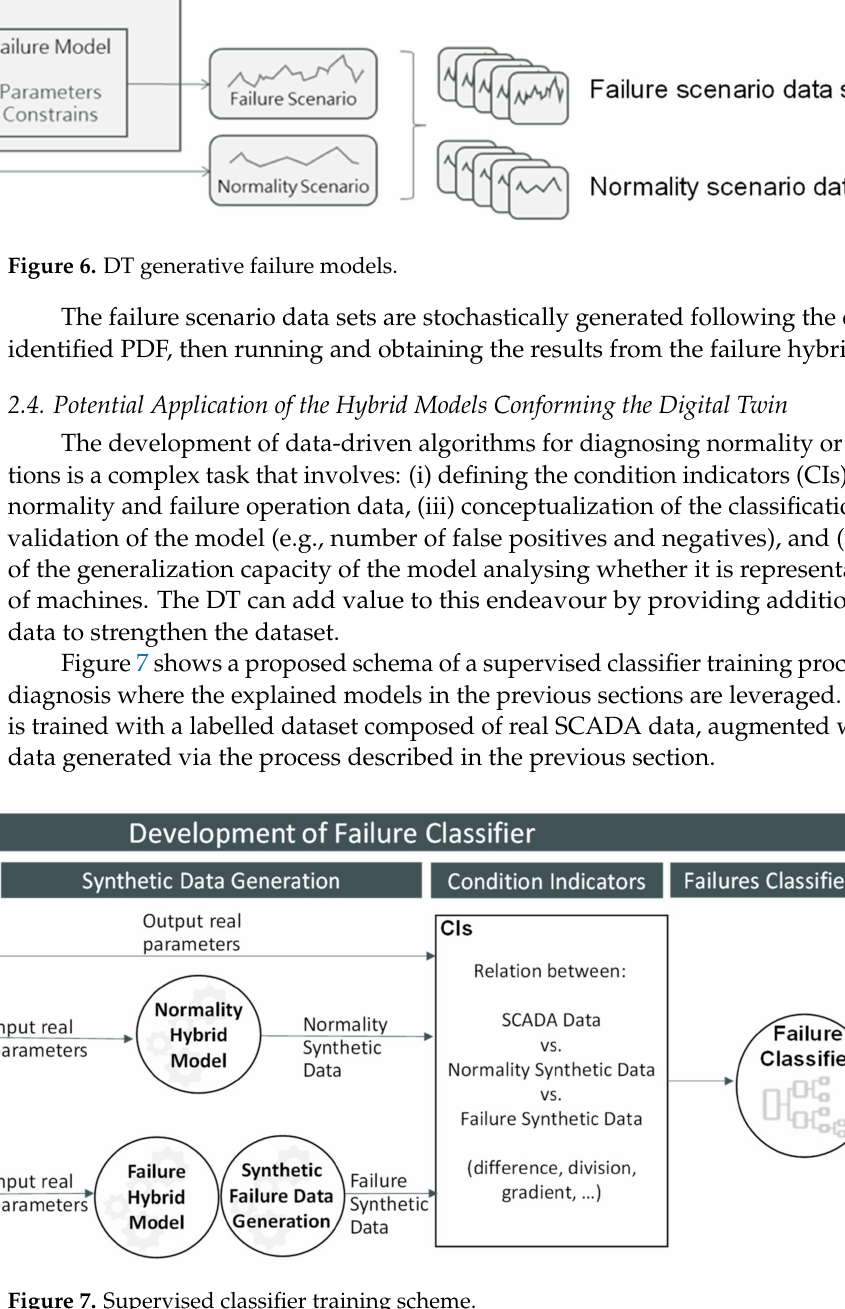
Figure 7. Supervised classifier training